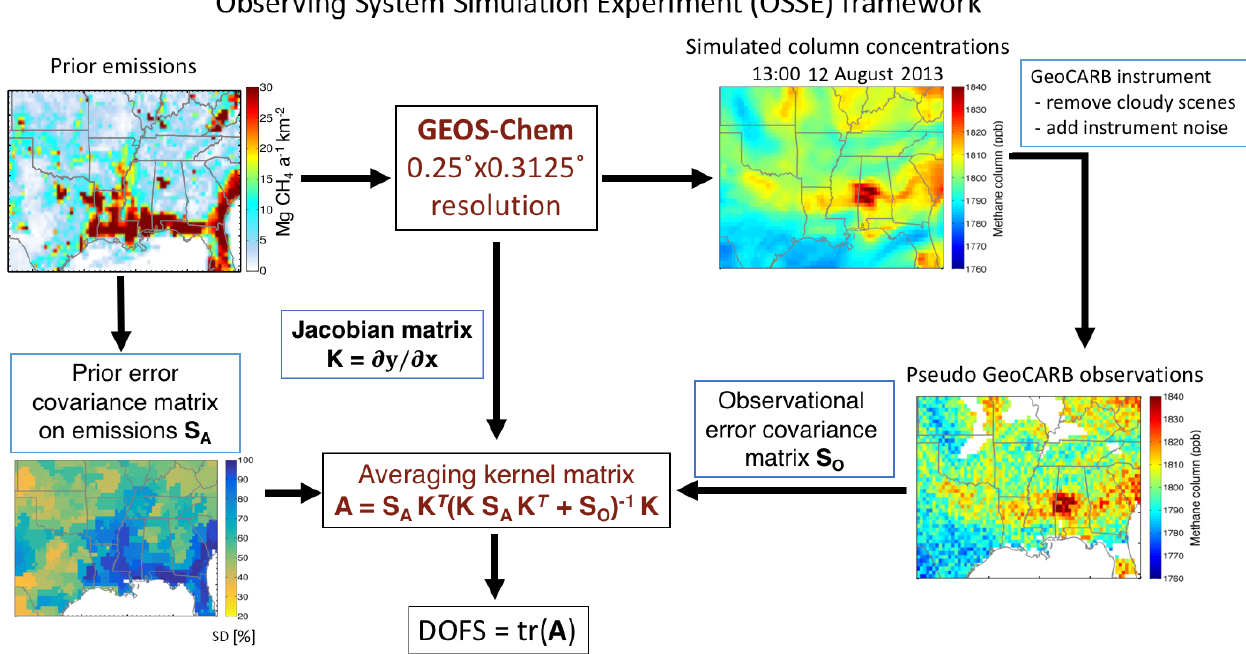
Figure 1. Observing System Simulation Experiment (OSSE) framework for the Southeast US to compare the ability of new satellite instru- ments to constrain methane emissions on the 25km (0 . 25 ◦ × 0 . 3125 ◦ ) scale. GeoCARB is used here as an example. The panels on the right show illustrative column concentrations and corresponding GeoCARB observations for a particular time. The column concentrations are in units of dry molar mixing ratio (ppb). White areas indicate full cloud cover or oceans preventing GeoCARB from making any observations on the 25km scale. The prior error covariance matrix on emissions S A is assumed diagonal and shown here as the corresponding relative error standard deviations. The degrees of freedom for signal (DOFS) is the trace of the averaging kernel matrix and measures the information content from the different satellite instruments. Table 1. Specifications of satellite instruments a